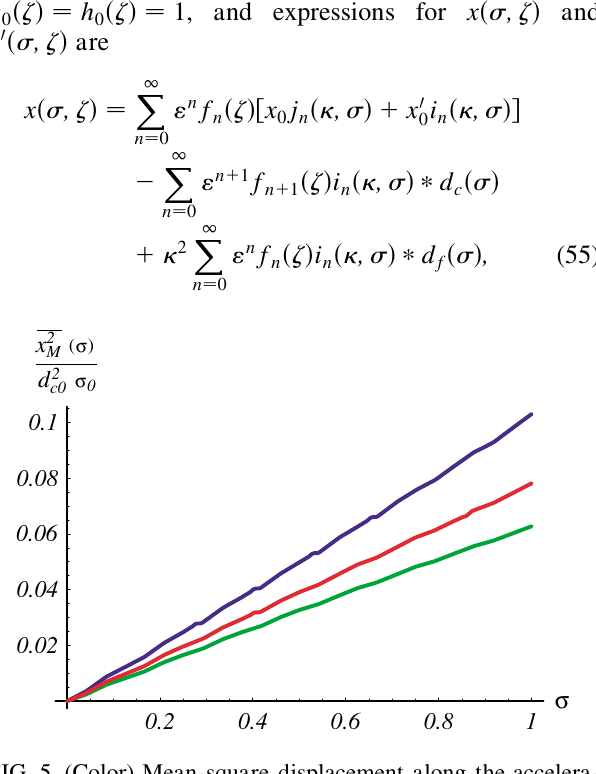
FIG. 4. (Color) Mean-square displacement of a train of point- like bunches at the exit of the accelerator due to cavity mis- alignment for " (cid:7) 0 : 1 , (cid:6) (cid:7) 100 , !) (cid:7) 4 : 01 (cid:29) , Q (cid:7) 1500 .